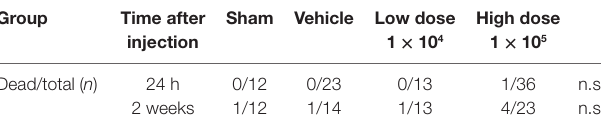
Table 2 | Mortality rate.